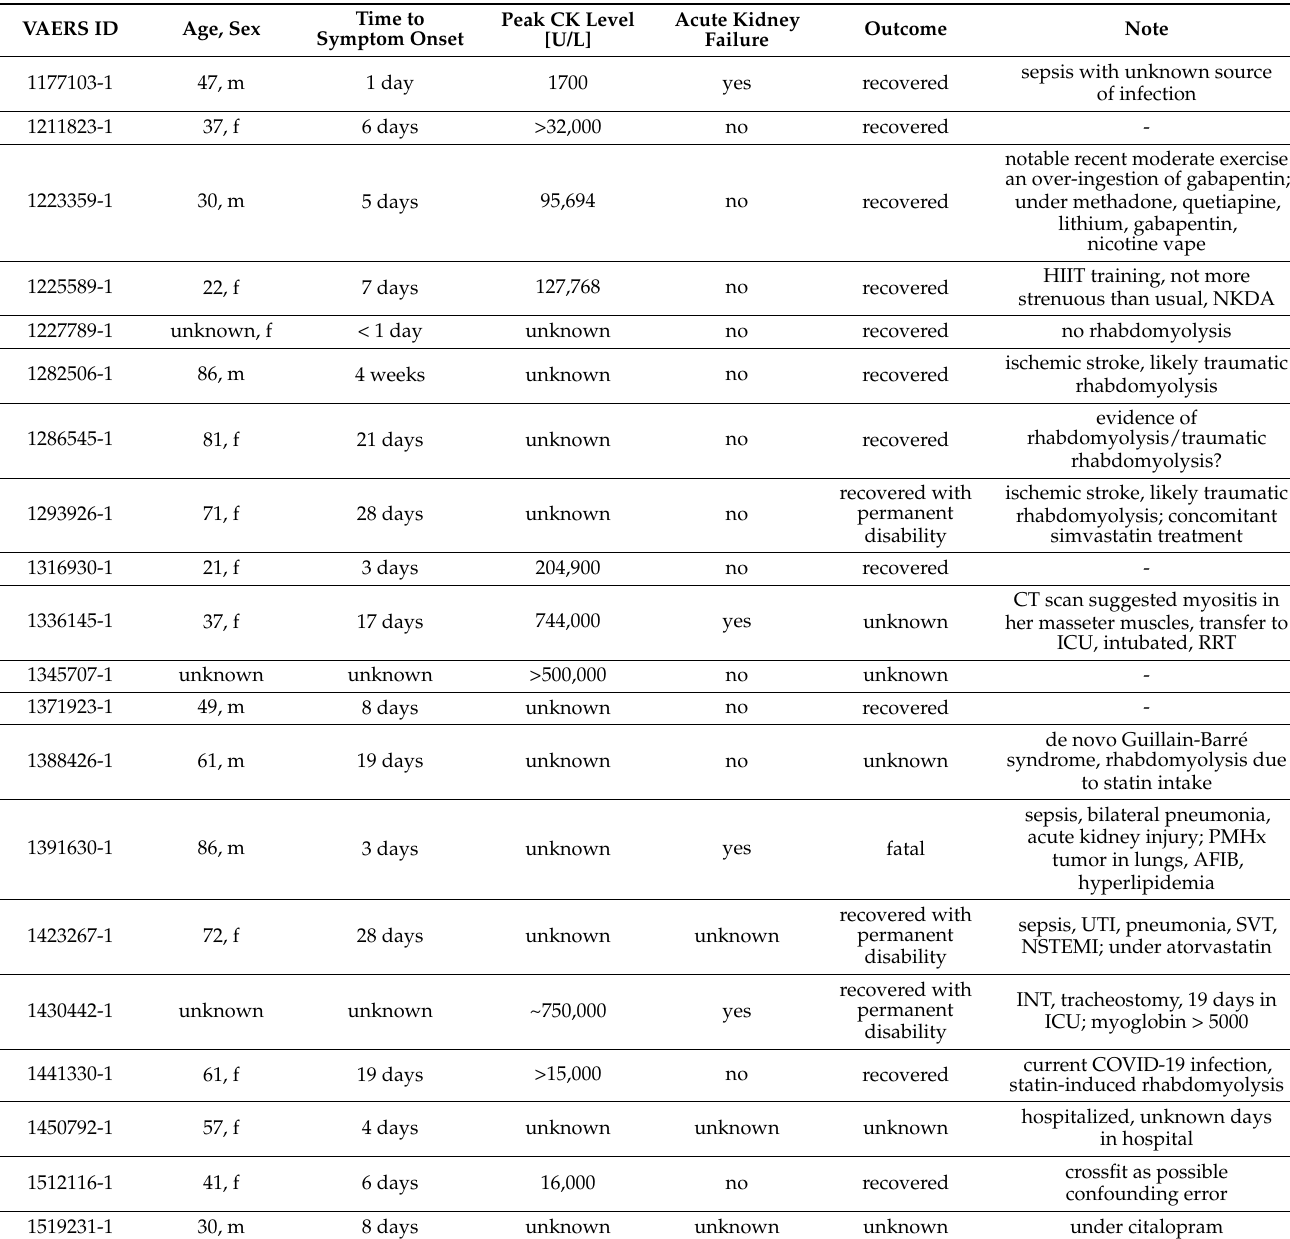
Table 3. Summary rhabdomyolysis cases following vaccination with Ad26.COV2.S, as captured in the vaccine adverse event reporting system (VAERS) (https://wonder.cdc.gov/vaers.html), last accessed on 24th August